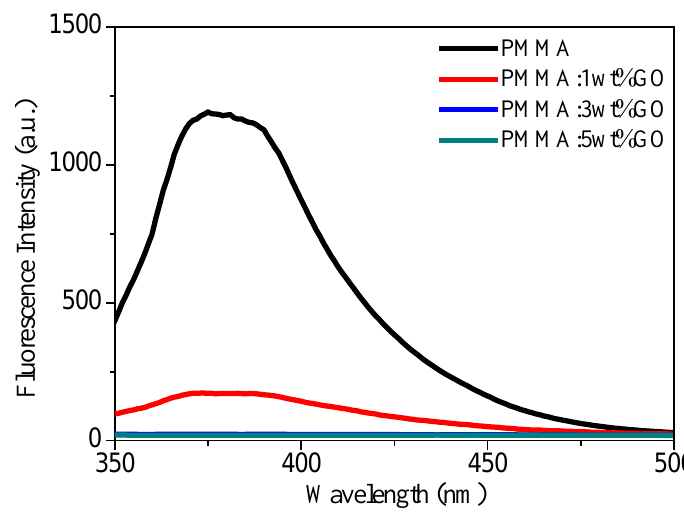
Figure 10. Fluorescence emission spectra excited at 320 nm for pure PMMA solutions, as well as the composite solution with a GO content of 1 wt %, 3 wt %, or 5 wt %.